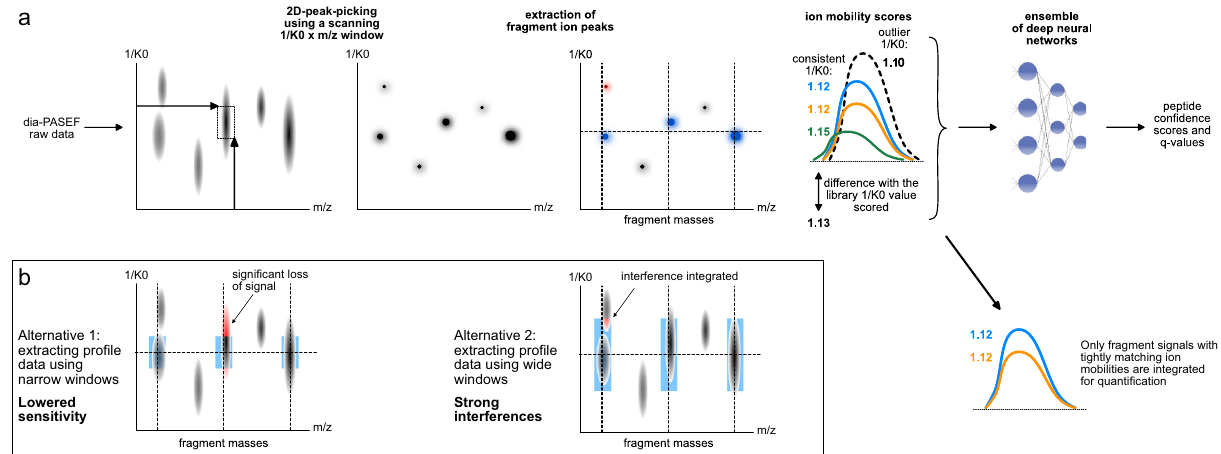
Fig. 1 A concept for processing of proteomic trapped ion mobility data. a Our dia-PASEF data processing work fl ow starts with 2D-peak-picking using a narrow scanning window. Chromatogram extraction is then performed, wherein for each precursor or fragment ion, only peaks within certain m/z and ion mobility thresholds from the expected values are used. Expected values are indicated here with dotted lines, peaks discarded due to m/z thresholding are indicated in gray, and a peak discarded due to only ion mobility thresholding is in red. Observed inverse ion mobility values (1/K0) are compared between different fragment ions (extracted chromatographic elution pro fi les and apex 1/K0 values of which are indicated with different colors) as well as to the reference library 1/K0 value (here: 1.13), to score putative peptide-spectrum matches. Fragments with outlier ion mobility values (here: black — signal from another peptide, green — signal mildly affected by interference) are assigned lower scores. The resulting data are analyzed by an ensemble of deep neural networks, used to distinguish true and false signals. Signals with deviating ion mobility values are also fi ltered out to increase quanti fi cation accuracy. b In contrast to the 2D-peak-picking introduced herein, direct extraction of chromatograms from the pro fi le data could potentially be used. In this case, if extracting pro fi le data with narrow windows (here: in blue), for example, the same size as used by the 2D-peak-picking algorithm, a signi fi cant proportion of ion signal can be lost (example highlighted in red) due to an imperfect match between theoretical and empirical m/z or 1/K0 values. If extracting with wide windows, more interfering signals would be integrated (example highlighted in red), increasing the complexity of the data and hampering correct identi fi cation and accurate quanti fi cation of